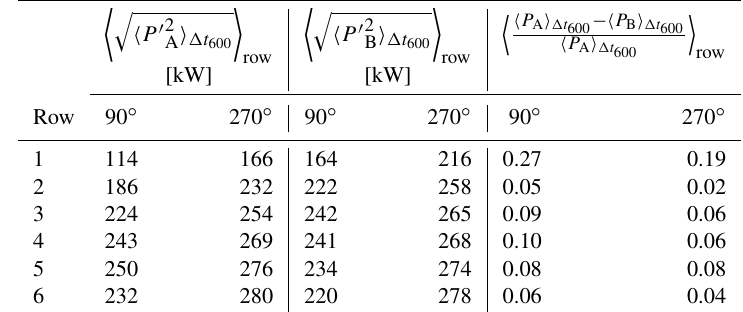
Table 3. Averaged wind turbine statistics per wind farm row computed for wind direction intervals around 90 and 270 ◦ with A as the upstream wind turbine and B as the downstream wind turbine. wind turbine A over a 600s interval (cid:49)t 600 (analogue for wind turbine B for the same 600s intervals). (cid:104) P A (cid:105) (cid:49)t average power outputs of wind turbines A and B over the same 600s intervals. (cid:104) ... (cid:105) row denotes the average of the statistics over all available time intervals of the wind turbine pairs in a row. Note that 90 and 270 ◦ again refer to the 20 ◦ wind direction intervals from 80 to 100 ◦ and from 260 to 280 ◦